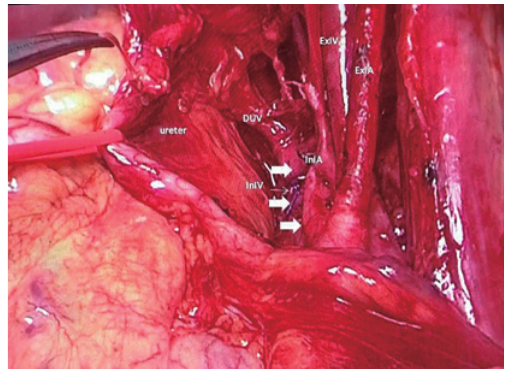
Fi g . 1 External iliac v essels and internal iliac v essels after s y